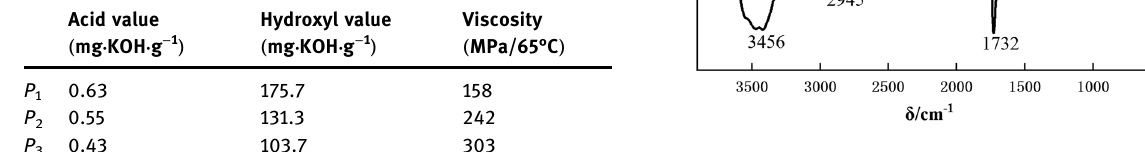
Figure 5: Infrared spectrum of PCL